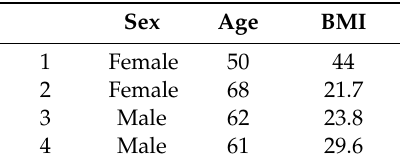
Table 1. Pancreatic islet donor